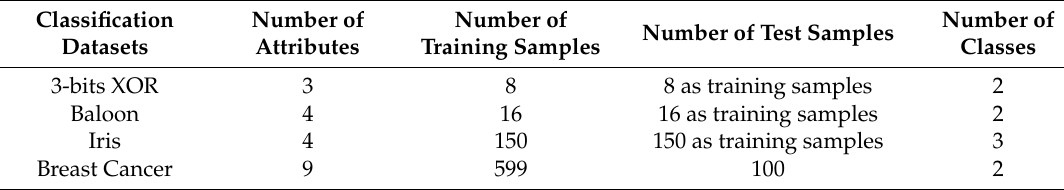
Table A1. Classification datasets (Mirjalili [48]).